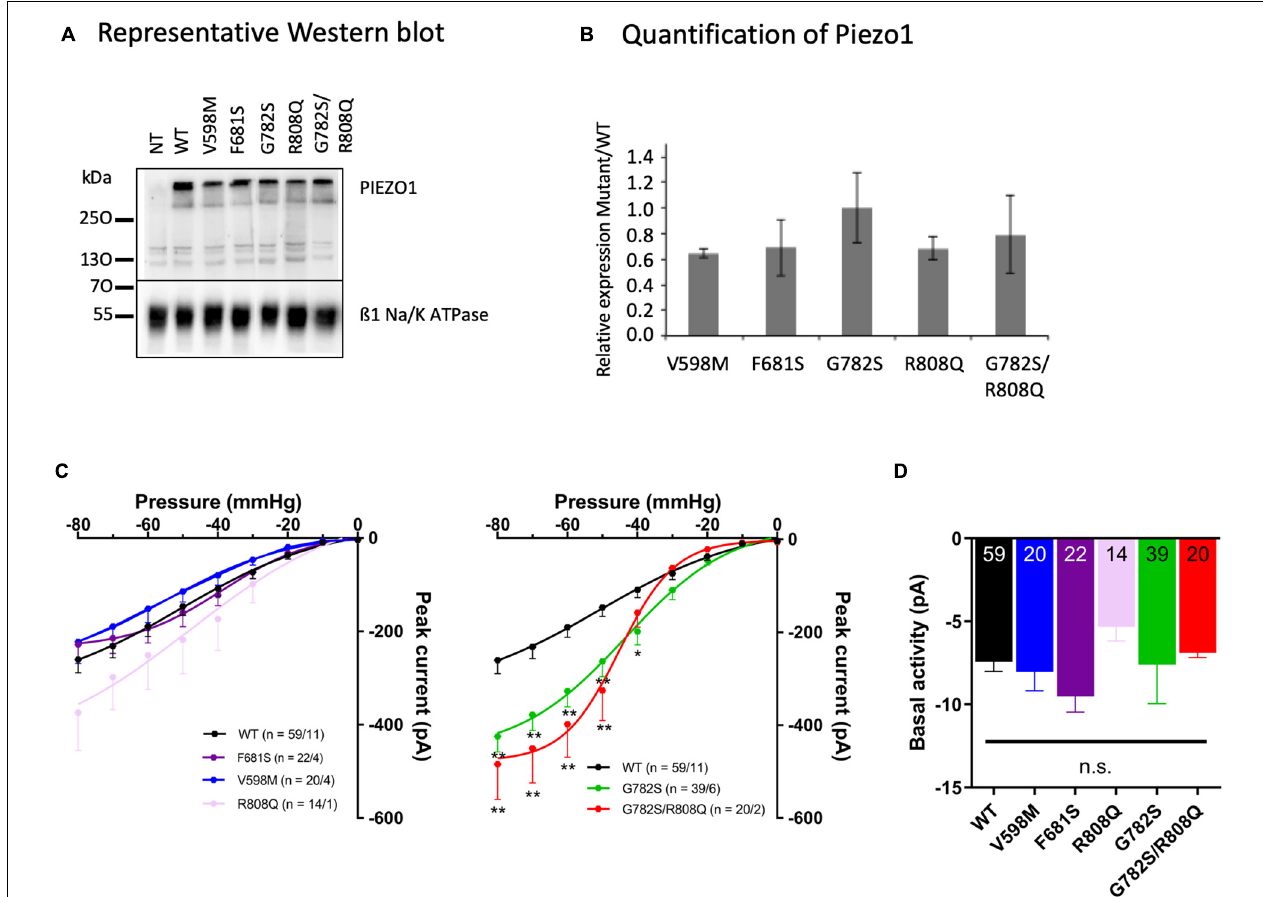
FIGURE 2 | (A) Representative Western blot (WB) from three different cell labeling done on three different batches of transfected cells. (B) Quantification of PIEZO1 mutant expression related to WT. A ratio of Na + /K + ATPase signal for each mutant versus WT was calculated for each WB and the PIEZO1 signal was corrected according to this internal standard. The plot illustrates the ratio Mutant/WT PIEZO1 calculated after five different WB (means ± sem). Statistical analyzes were done with Kruskal and Wallis test and differences were not significant ( p > 0.05). (C) Stretch-activated currents of PIEZO1 WT and mutants, expressed in HEK293T cells, recorded in cell-attached configuration. Bars represent the mean ± sem, and the number of cells tested/the number of cell transfections is shown as n in the figures. ** p < 0.01; * p < 0.05 vs. WT, two-way analysis of variance with Bonferroni’s post hoc . (D) Basal activity of PIEZO1. Basal activity calculated from the current traces without additional negative pipette pressure application, showing no significant differences between eGFP without PIEZO1, WT, and mutant constructs. Bars represent the mean ± sem, and the number of cells tested is shown in the bottom of the bars. n.s., not significantly different, one-way analysis of variance with Bonferroni’s post hoc